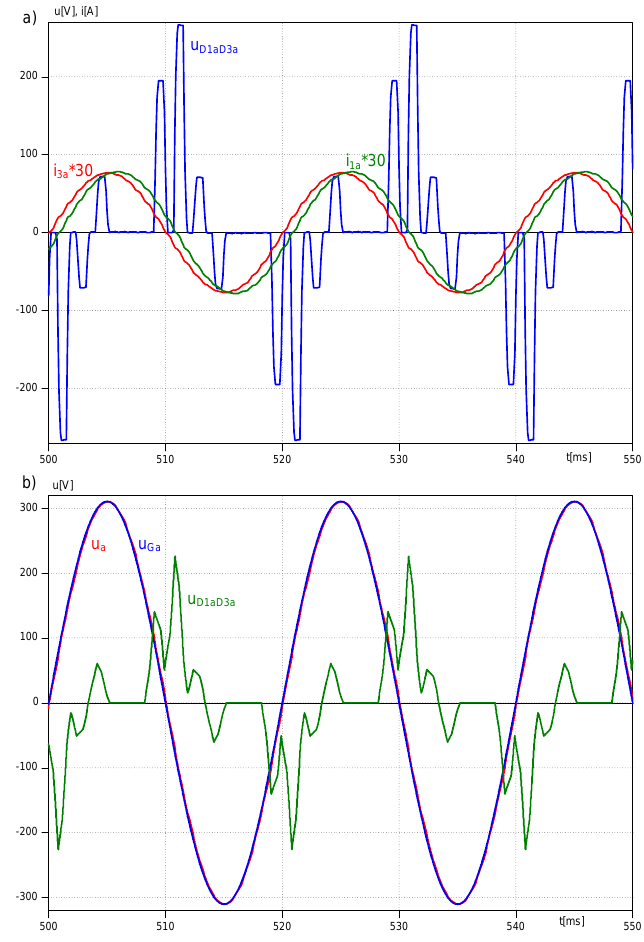
Figure 18. Output current i 1a , i 3a and voltage u D1aD3a waveforms of the 3CRλ2 unit: ( a ) rated load, ( b ) 10% load.